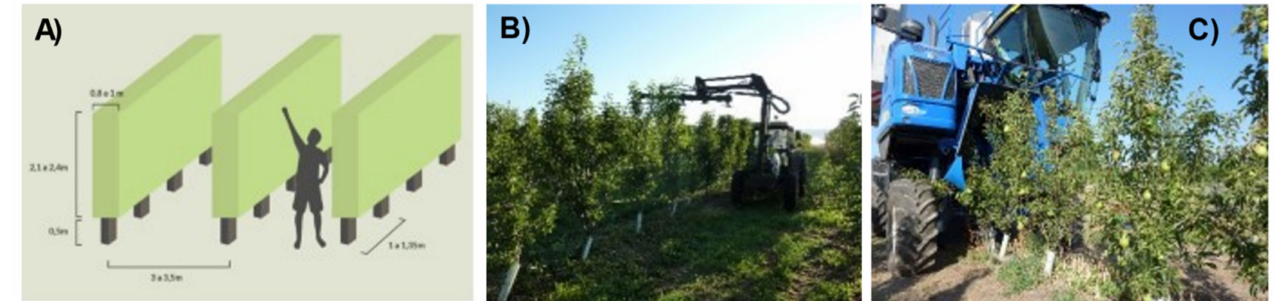
Figure 6. Schematic of the hedge system used for pear production ( A ), photos of the hedge system being pruned mechani- cally ( B ) and harvested by over-the-row harvesters ( C ) (Photos: courtesy of A. Blanco,